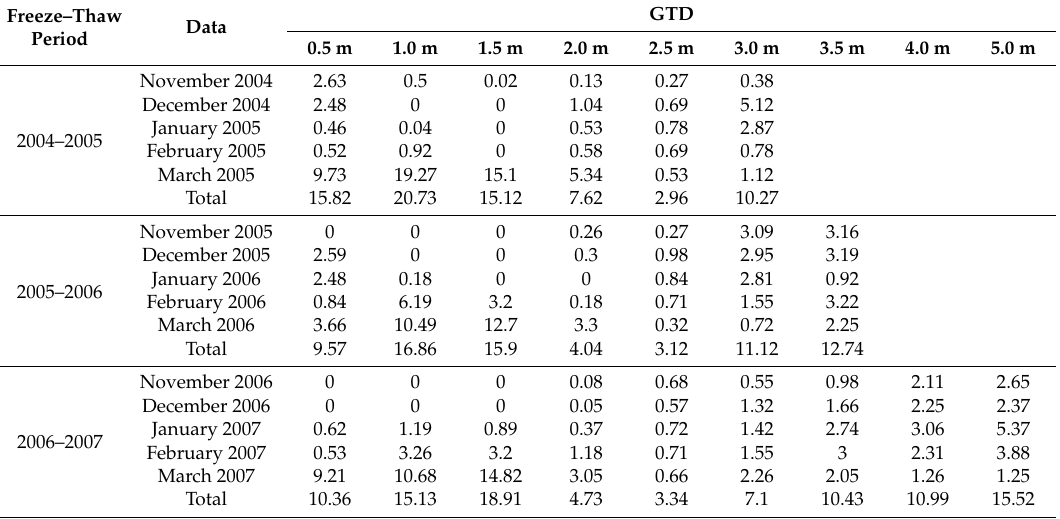
Table 7. Recharge to phreatic water with sandy loam during freeze–thaw periods. Unit: Millimeters. Freeze–Thaw Period